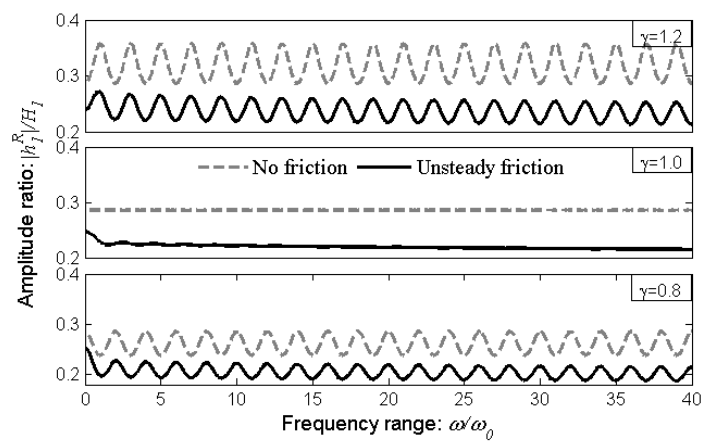
Figure 4. Impacts of the Darcy–Weisbach steady friction model ( 0.04 with three VSI conditions.